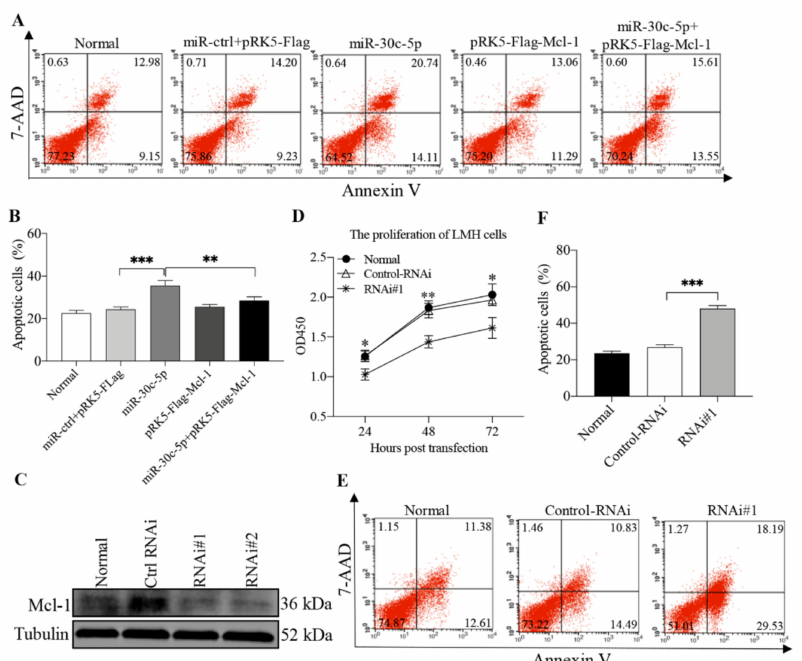
Figure 6. Overexpression of Mcl-1 blocked gga-miR-30c-5p-induced apoptosis in LMH cells, and the knockdown of Mcl-1 promotes apoptosis in LMH cells. ( A ) The LMH cells were co-transfected with gga-miR-30c-5p mimics (80 nM) or miRNA controls (80 nM), pRK5-Flag-Mcl-1(1 µ g), or pRK5-Flag (1 µ g). Forty-eight hours after transfection, the cells were collected, stained with Annexin V-PE and 7-AAD, and examined for apoptosis by flow cytometry. ( B ) The percentage of apoptotic cells in each group in panel ( A ) was graphed and statistically analyzed. ( C ) Effects of Mcl-1 RNAi on the expression of endogenous Mcl-1. The LMH cells were transfected with siRNA (RNAi#1 and RNAi#2) or controls. Twenty-four hours after the second transfection, cell lysates were prepared and examined by Western Blot using anti-Mcl-1 and anti-Tubulin antibodies. Endogenous Tubulin expression was examined as an internal control. ( D ) The knockdown of Mcl-1 by RNAi suppressed the viability and proliferation of cells. The LMH cells were seeded on a 96-well culture plate and transfected with Mcl-1-RNAi#1 or control-RNAi at a final concentration of 60 nM. At different time points (24, 48, and 72 h) post-transfection, 10 µ L of CCK-8 solution was added to each well, followed by incubation at 37 ◦ C for 1 h, and the absorbance of the solution was finally determined at 450 nm using a microplate spectrophotometer. ( E , F ) The knockdown of Mcl-1 promotes LMH cells apoptosis. The LMH cells were double transfected with siRNA (RNAi#1) or RNAi controls at an interval of 24 h. Twenty-four hours after the second transfection, the cells were collected, stained with Annexin V-PE and 7-AAD, and examined for apoptosis by flow cytometry. The percentage of apoptotic cells in each group in panel ( D ) was graphed and statistically analyzed ( E ). Data are representative of three independent experiments and presented as means ± SD. (*** stands for p < 0.001; ** for p < 0.01; * for p <